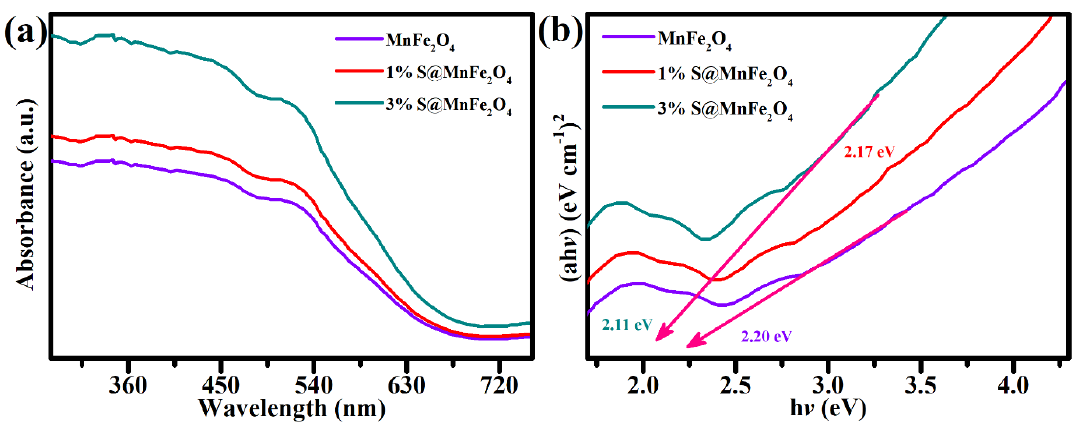
Figure 6. ( a ) UV–vis absorption measurements and ( b ) Tauc’s plots of MnFe 2 O 4 , 1% S@MnFe 2 O 4 , and 3% S@MnFe 2 O 4 .